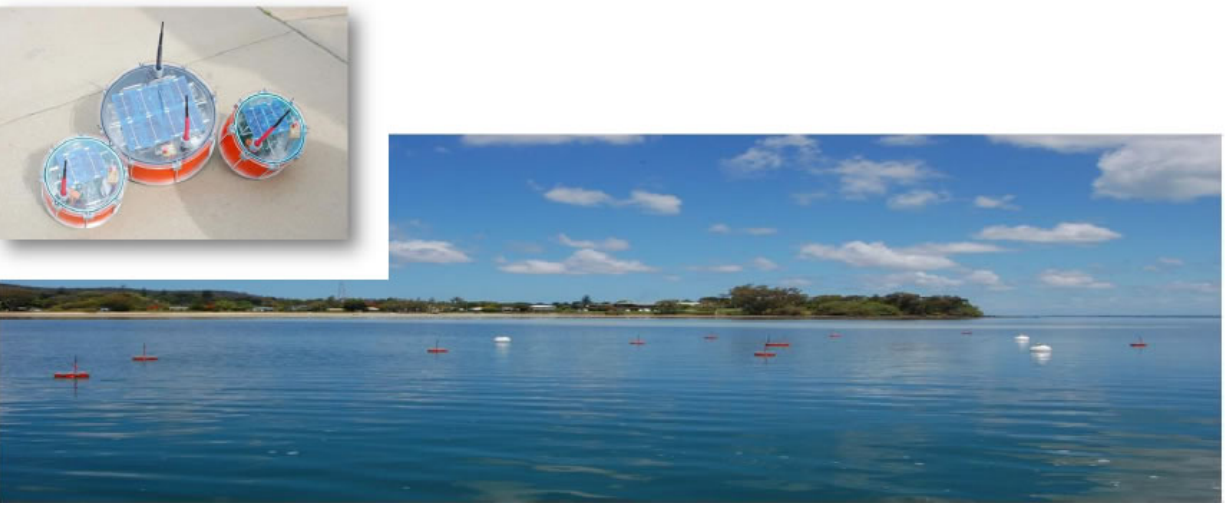
Figure 4. The SEMAT Mk1 prototype buoy. Examples of the gateway and surface nodes and the system deployed at Moreton Bay,